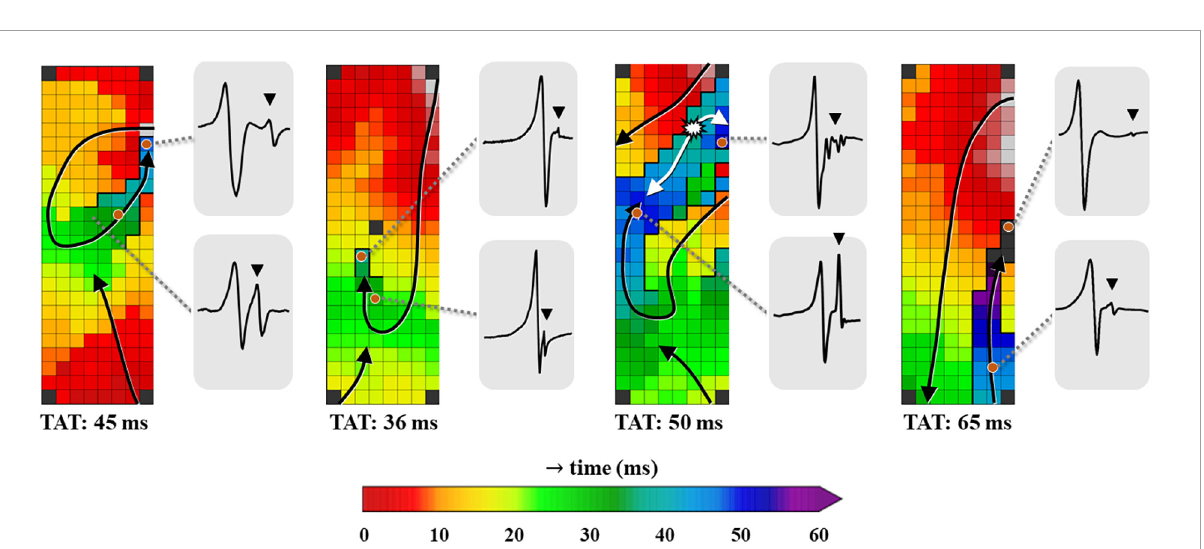
FIGURE3 Four examples of color-coded activation maps containing LOMs derived from different patients, constructed using all unipolar deflections. Examples of corresponding EGMs recorded at distinct locations of the LOM are shown outside the activation map, demonstrating the variable morphology of LOM potentials. EGM, electrogram; LOM, ligament of Marshall; TAT, total activation time. The bold black lines represent lines of conduction block and the black triangle in the EGM indicates a LOM potential. The white asterisk indicates a focal pattern of